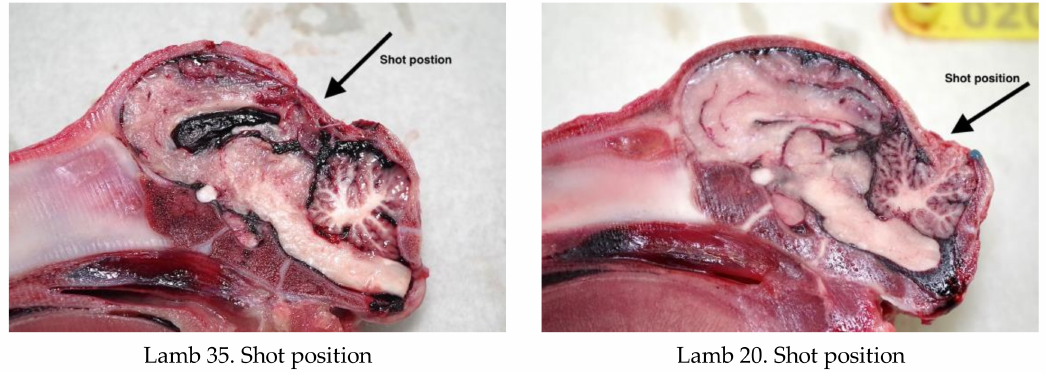
Figure 11. Variation in shot position and macroscopic brain damage in lamb head sagittal